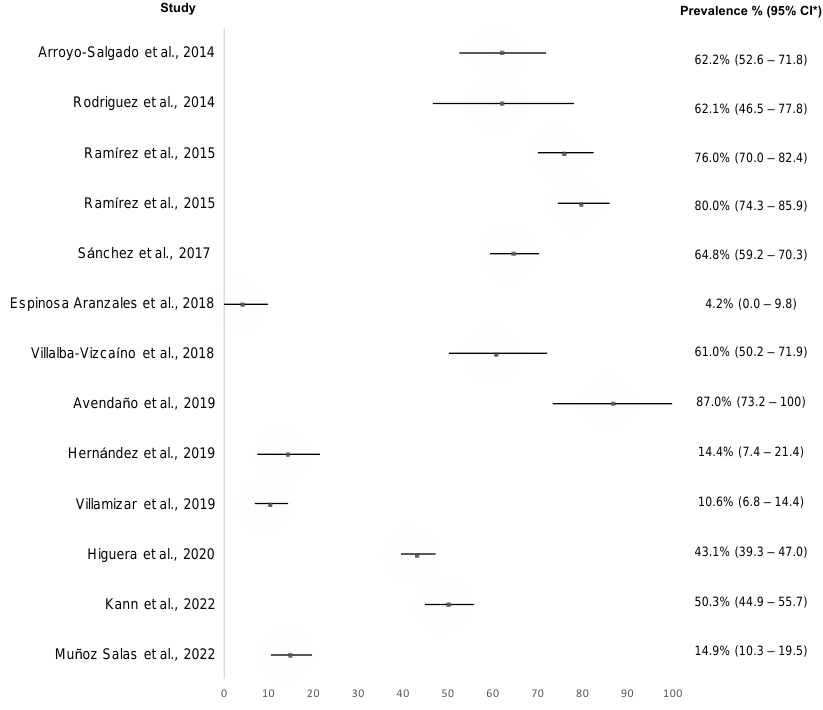
Figure 3. Reported prevalence of Giardia in the included studies by molecular method [40,41,44,46,47,49,50,52,54,55,57,58]. The prevalence with microscopy methods varied between 0.9% (C.I. 0 – 1.9%) [47] and 100% (C.I. 100 – 100%) [40]. Overall, of the 23 investigations that used microscopy, 8 papers showed more than 25.0% prevalence of Giardia in Colombian individuals [39,40,42,48,49,52,55,59] (Figure 4).